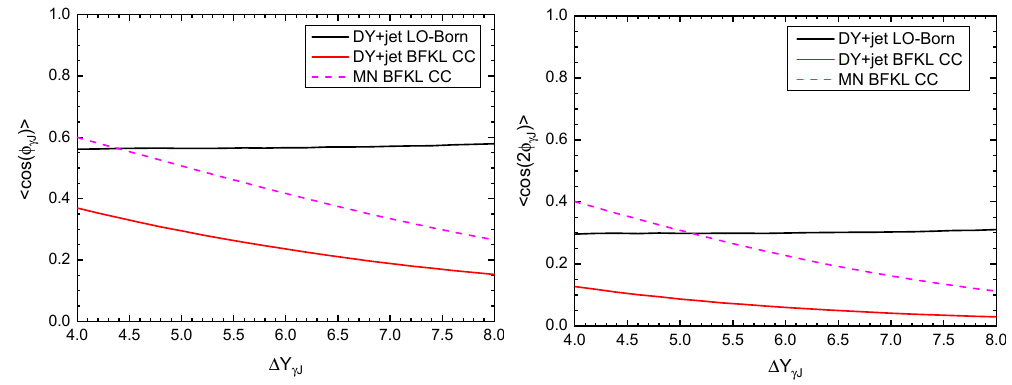
Figure 5 . The mean cosine of the photon-jet angle h cos( n(cid:30) (cid:13)J ) i for n = 1 (left) and n = 2 (right) for the DY+jet (solid lines) and the MN jets (dashed line) as a function of the rapidity di(cid:11)erence (cid:1) Y (cid:13)J . The parameters are the following q ? = p I ? = 25 GeV, p J ? = 30 GeV and M = 35